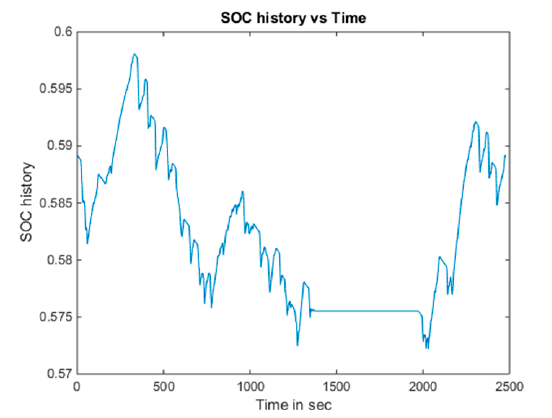
Figure 4. State of Charge (SOC) history.